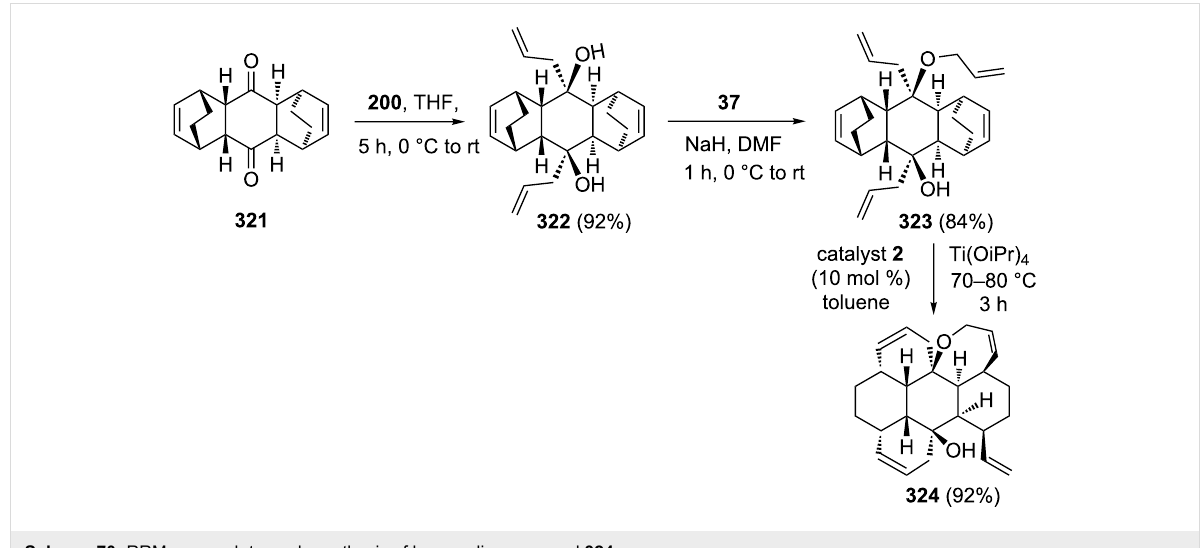
reaction between 1,3-cyclohexadiene and 1,4-benzoquinone. Further, treatment of 323 with catalyst 2 in the presence of tita- nium isopropoxide furnished the expected RRM product 324 in 92% yield (Scheme